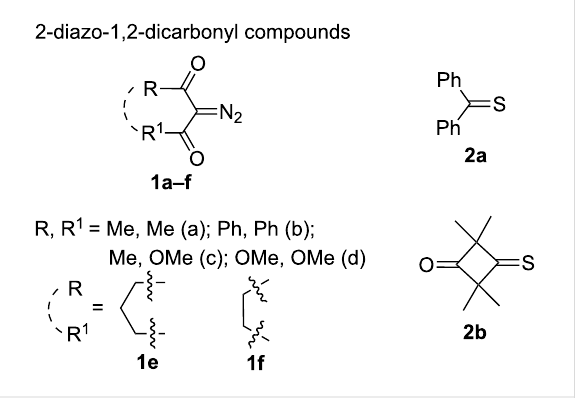
Figure 1: Diazo compounds 1 and thioketones 2 used in the